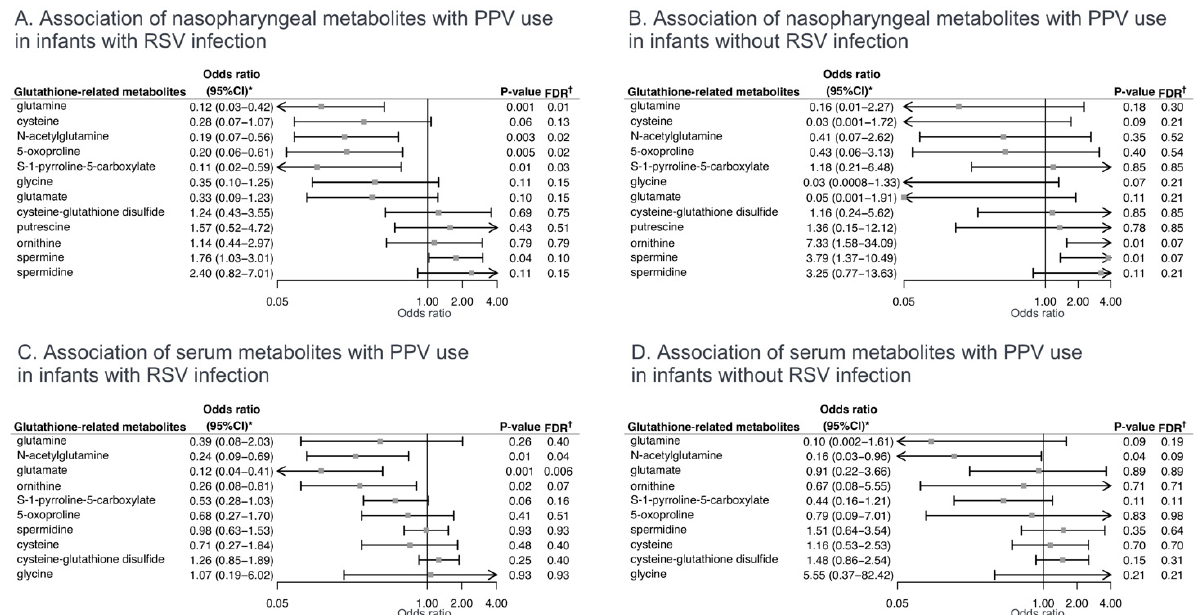
Figure 4. Stratified analysis of associations of nasopharyngeal and serum glutathione-related metabolites with severity outcome in infants hospitalized for bronchiolitis, by respiratory syncy- tial virus infection. ( A ). Multivariable-adjusted association of nasopharyngeal glutathione-related metabolites with PPV use in infants with RSV infection. The ORs were estimated for a 1% change in the relative abundance of metabolites. ( B ). Multivariable-adjusted association of nasopharyngeal glutathione-related metabolites with PPV use without RSV infection. The ORs were estimated for a 1% change in the relative abundance of metabolites. ( C ). Multivariable-adjusted association of serum glutathione-related metabolites with PPV use with RSV infection. The ORs were estimated in a 2-fold change in the abundance of metabolites. ( D ). Multivariable-adjusted association of serum glutathione-related metabolites with PPV use without RSV infection. The ORs were estimated in a 2-fold change in the abundance of metabolites. Arrows indicate that the 95%CI of the odds ratio exceeds the lower or higher limit of the x -axis. * Estimated by fitting logistic regression model adjusting for potential confounders (age and sex). † The Benjamini–Hochberg FDR method was used to account for multiple testing. Abbreviations: CI, confidence interval; FDR, false discovery rate;